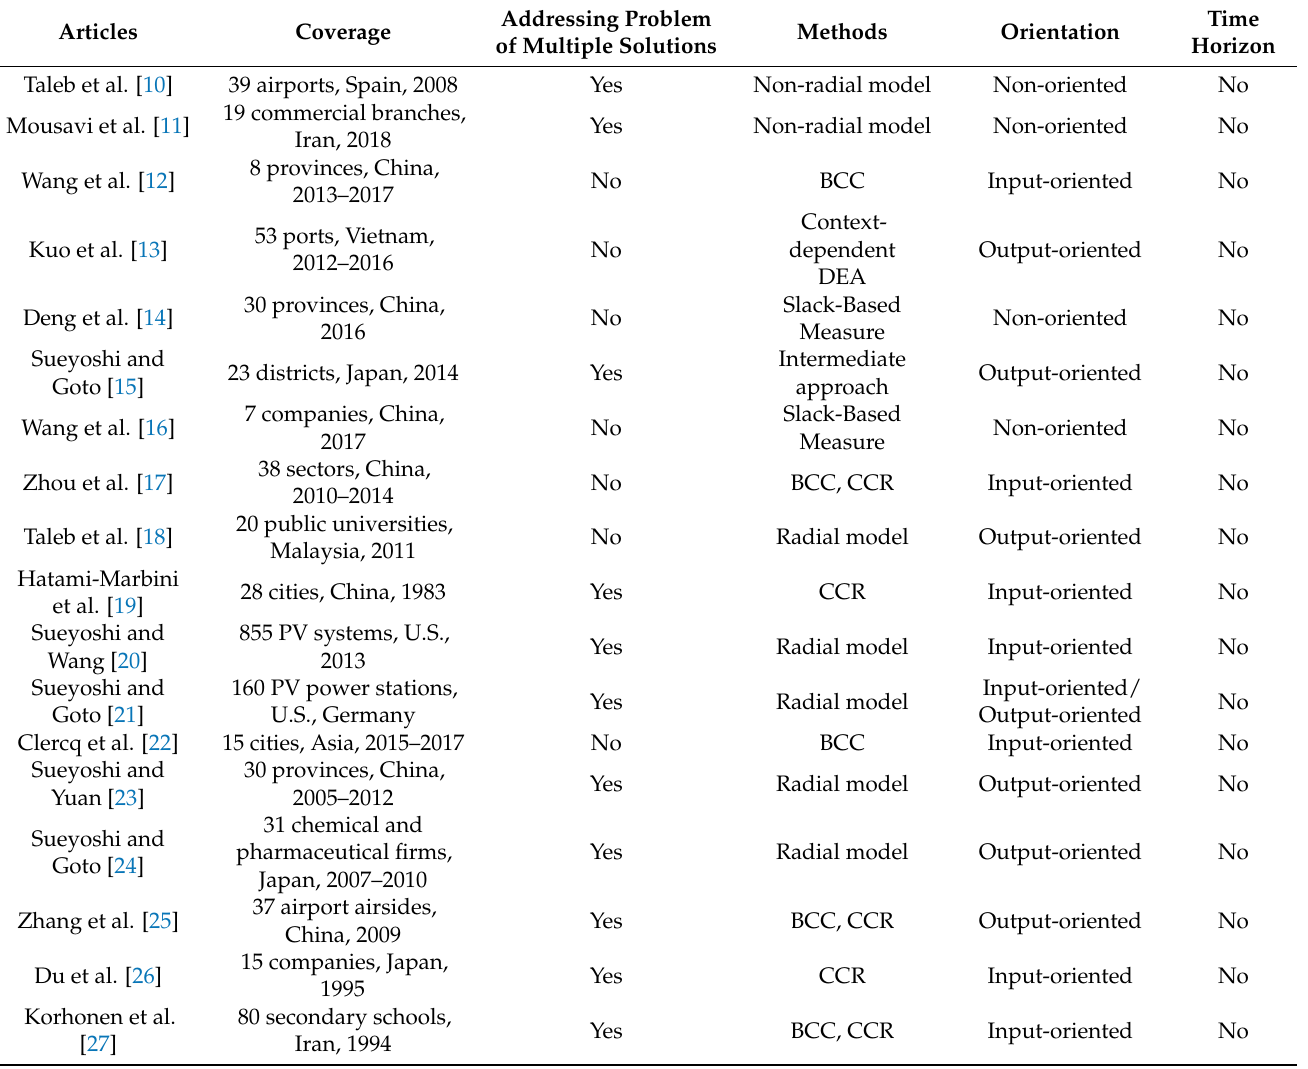
Table 1. Recent studies on DEA-based RTS